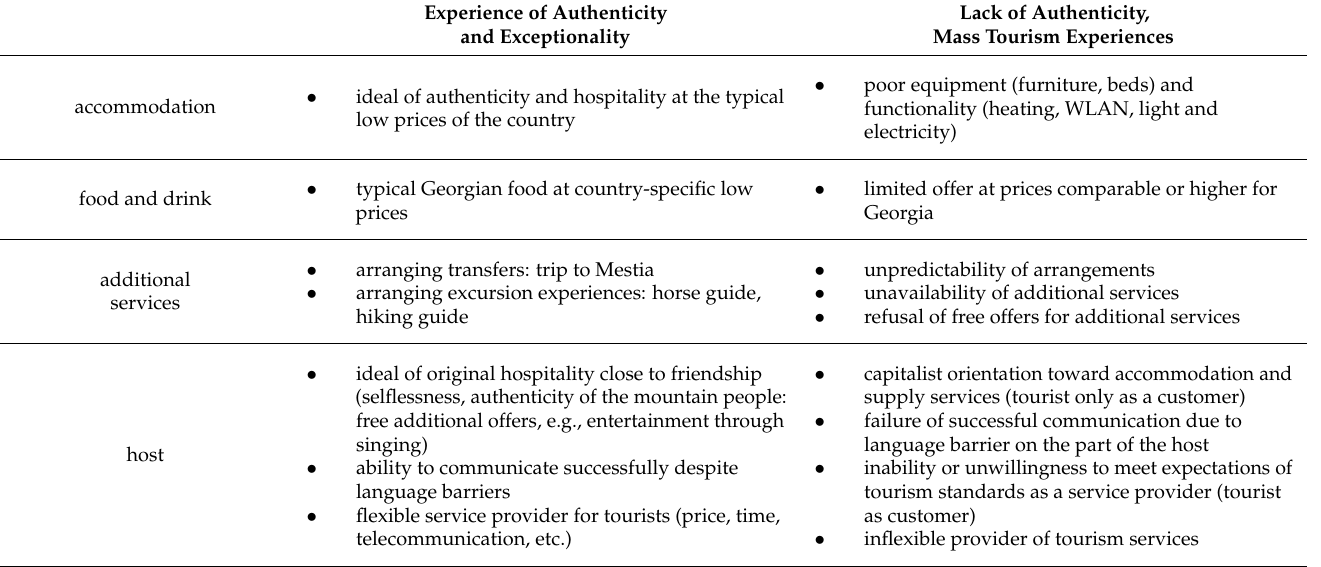
Table 2. Between enthusiasm and disapproval—poles of internet comments about homestays in Ushguli (Svaneti,